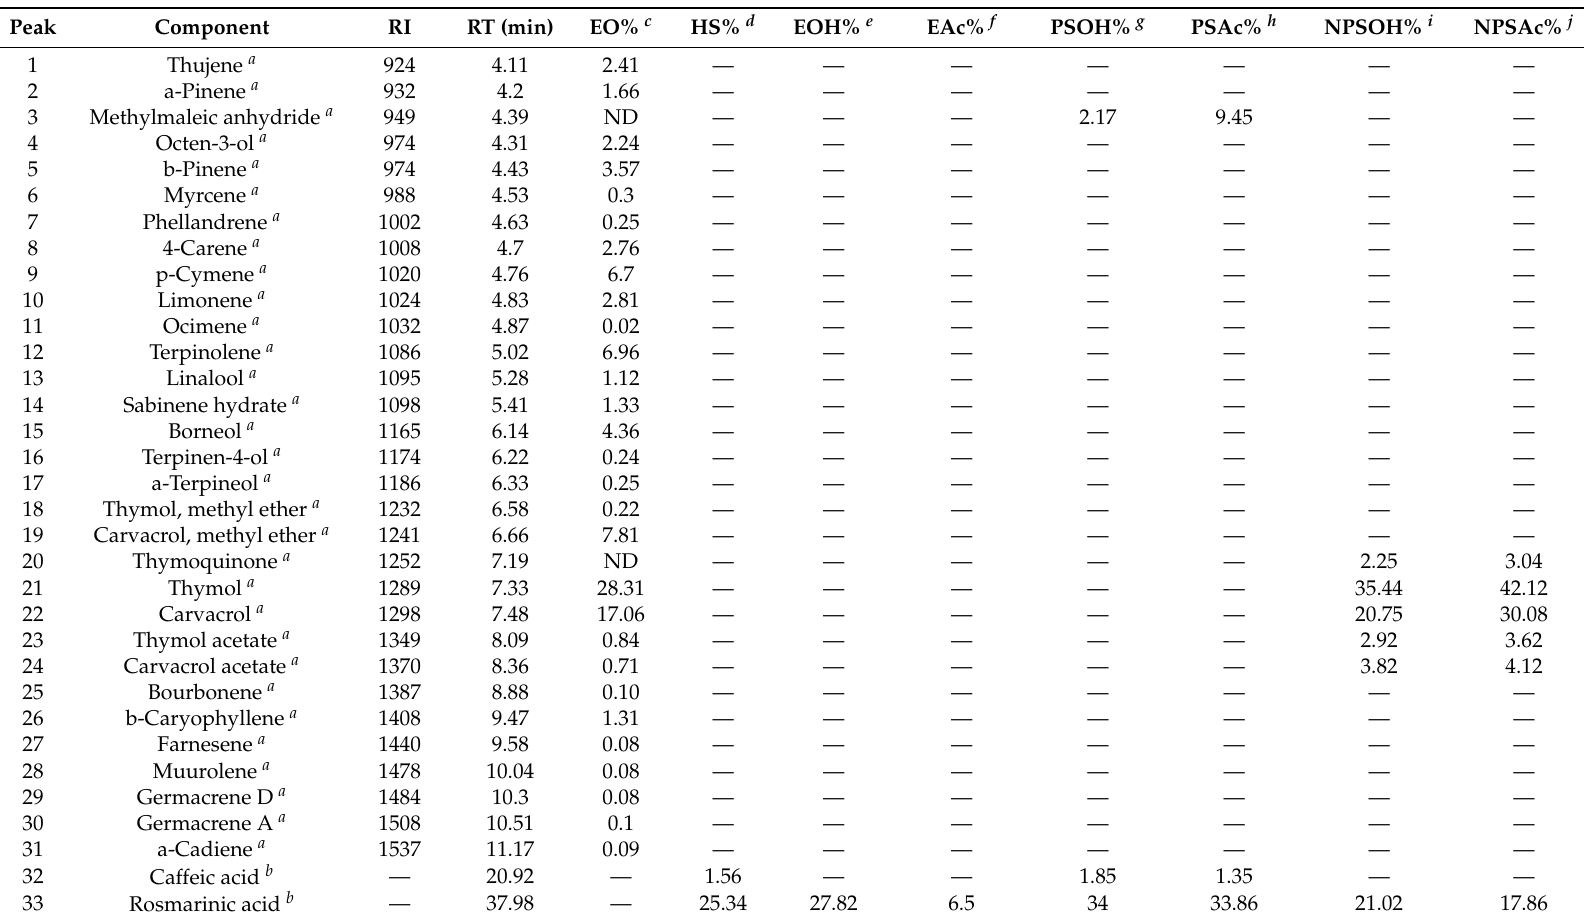
Table 1. Chemical composition, retention index, and retention time (min) of P. longiflora Mexican oregano essential oil, hydrosol and extracts from waste solid residues. Peak